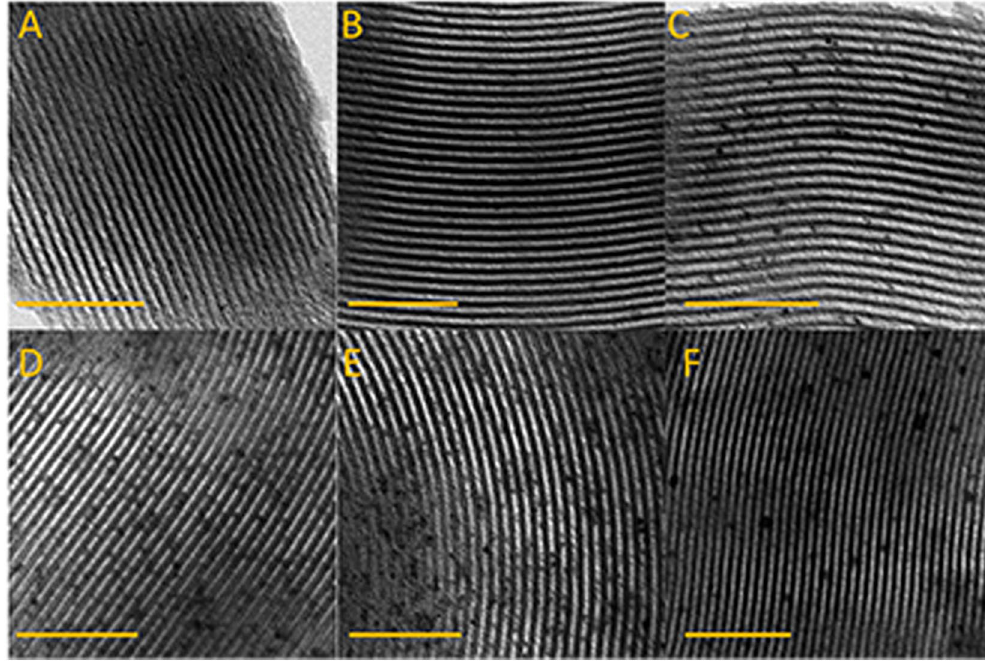
Figure 3. TEM images for the samples of ( A ) 0.5PtAS, ( B ) 1.0PtAS, ( C ) 3.0PtAS, ( D ) 5.0PtAS, ( E ) 10.0PtAS, and ( F ) 5.0PtCS. Scale bars represent 100